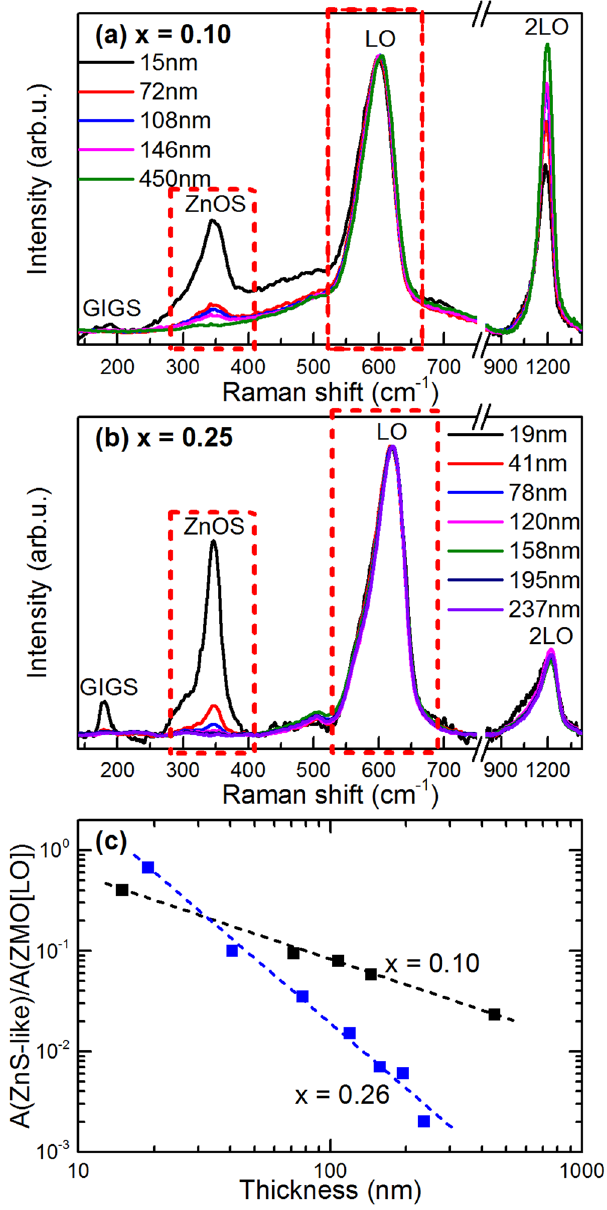
Figure 6. Raman spectra (normalised to the intensity of the main LO peak) measured from series (ii– a ) and (iii– b ) layers. ( c ) Relative intensity of the ZnS-like peak from the Zn(O,S) subjacent layer in relation to the main LO ZnMgO Raman peak (corresponding to the peaks highlighted in red in the Raman spectra) versus the layer thickness for layers series (ii) (Mg/(Mg + Zn) relative content 10%) and layers series (iii) (Mg/(Mg + Zn) relative content 26%). Dotted lines correspond to the fitting of the data with linear relationships in the log-log